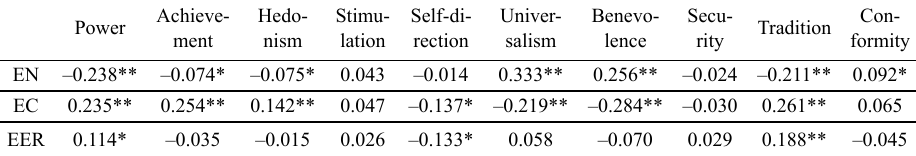
Table 3. The direct effect of types of personal values on ATEN, ATEC, and EER Achieve- Hedo- Stimu- Power ment nism lation